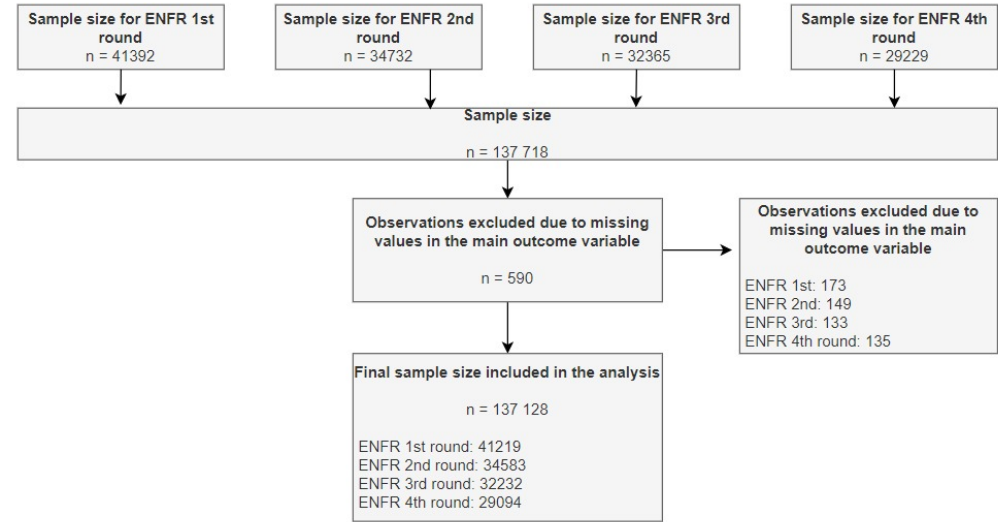
Figure 1. Study Figure 1. Study flowchart.